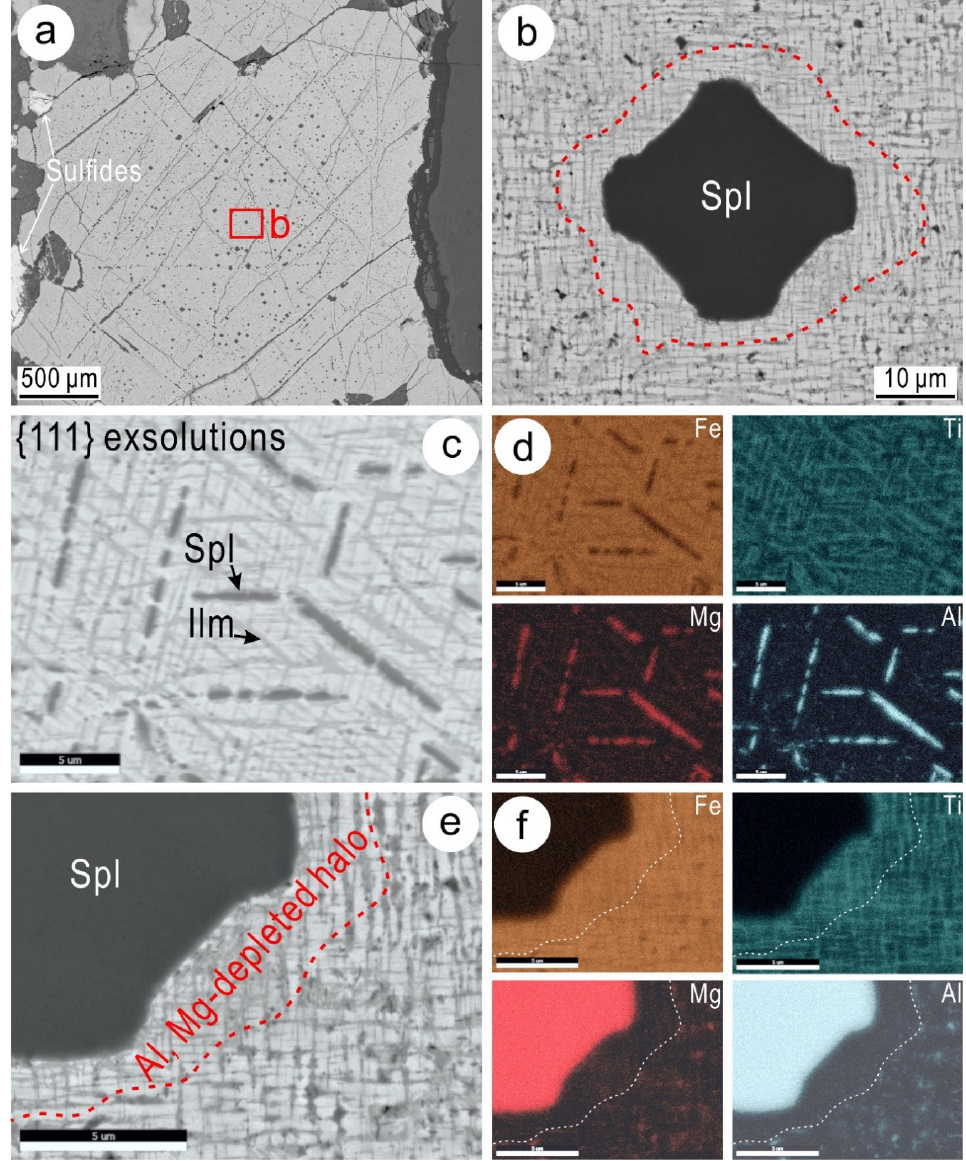
Figure 1. Back-scatter electron (BSE) images ( a , b ) and BSE images with SEM-EDS maps ( c – f ) showing µm-scale textural complexity in titanomagnetite (Ti-Mt) from Panzhihua. ( a ) Grain displaying coarser spinel (Spl) inclusions throughout the core, crosscutting fractures, and marginal replacement by silicates. Note the presence of a sulfide grain (arrowed) close to the grain boundary. ( b ) Detail of area representative of {100} ilmenite (Ilm) + spinel inclusions with relatively coarse, square-shaped spinel in the center. Note the absence of smaller spinel grains within the halo surrounding the coarser inclusions (red dashed line). ( c , d ) Typical {111} sets of exsolutions in titanomagnetite comprising ilmenite and spinel. ( e , f ) Detail showing the halo surrounding the spinel inclusion in ( b ) with Al and Mg depletion.